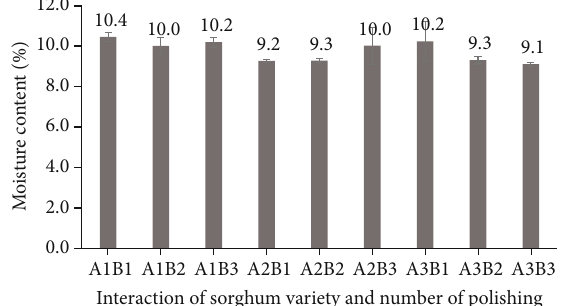
Figure 17: Water content (by di ff erence) of three varieties of polished sorghum grains at di ff erent polishing frequencies.